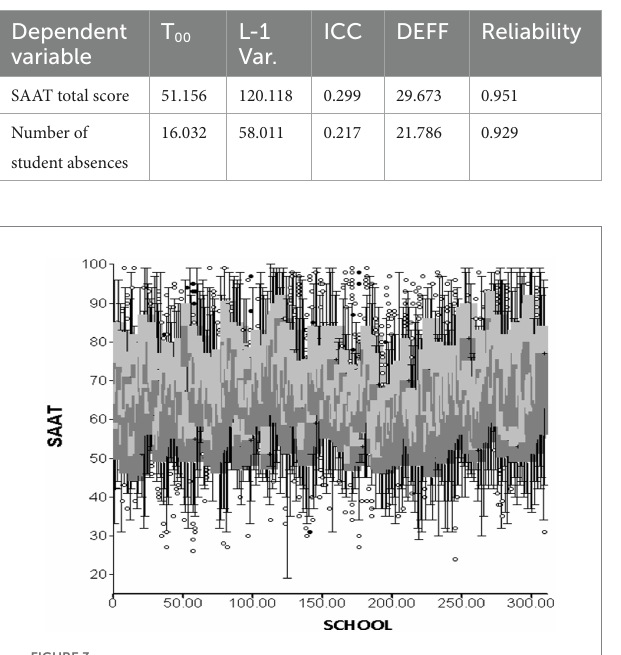
FIGURE 3 Variability of schools across SAAT scores; figure displays boxplots for a random. Number of schools (10% of them for clarity).